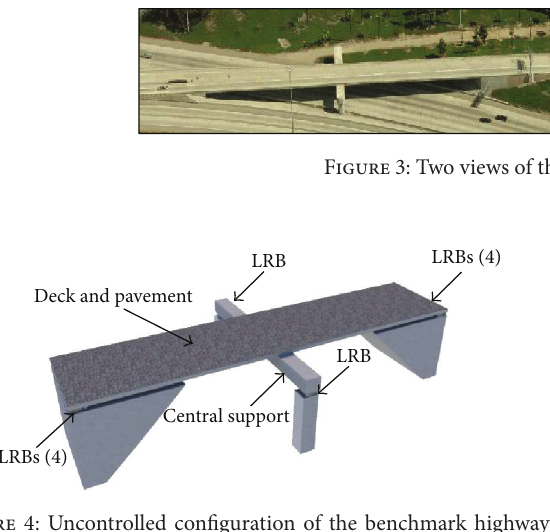
Figure 4: Uncontrolled configuration of the benchmark highway